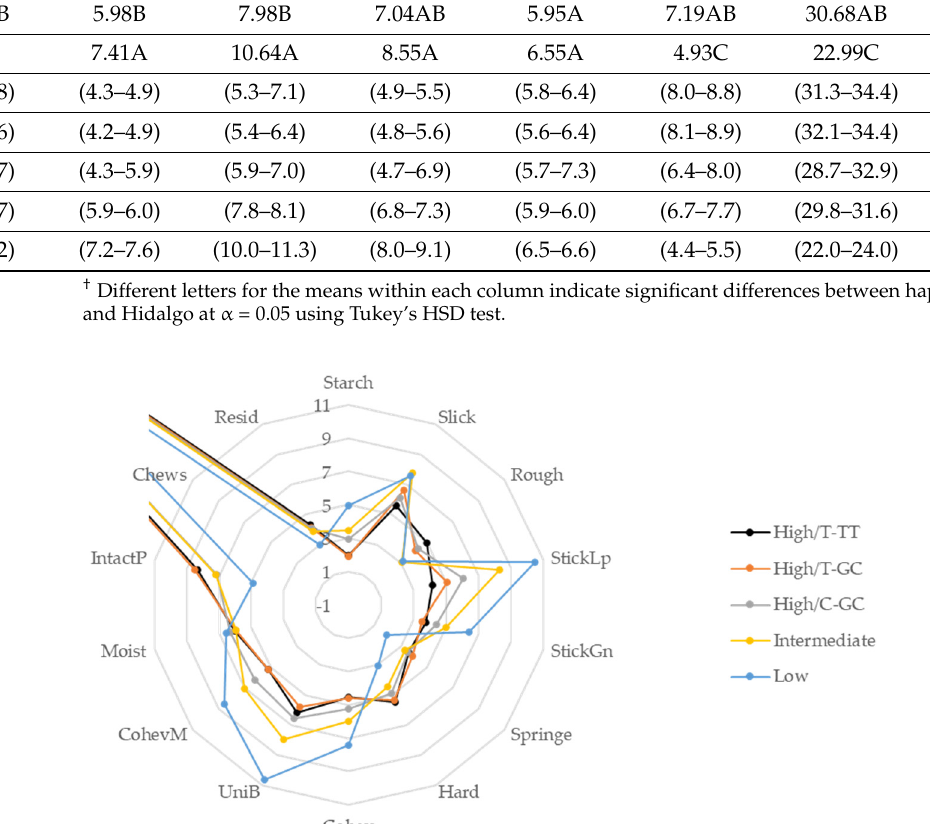
Pairwise correlation of grain quality traits with the texture attributes is presented in Table S5. RS and protein were positively ( r = 0.47 and 0.49, respectively, both at p < 0.05) and Tp was negatively correlated with Rough ( r = − 0.59, p < 0.01). Protein was also posi- tively correlated with StickGn ( r = 0.45, p < 0.05). Tp was also positively correlated with Starch, StickLp and negatively with residuals ( r = 0.52 at p < 0.05; r = 0.65 at p < 0.01; r = − 0.45 at p < 0.05, respectively). Pairwise correlation among texture attributes of high am- ylose varieties showed that some attributes were highly correlated with others, specifi- cally, Starch, CohevM, IntactP, Hard, and Cohev. PCA analysis of grain quality traits and texture attributes of high amylose varieties are presented in Table 7 and Figure 3. The first three PCAs accounted for a total of 63.3% variance with PC1, PC2 and PC3 having 36.6%, 15.9% and 10.9%, respectively. PC1 in- cluded (eigenvector > |0.25|) positive loadings of Starch, StickLp, Cohev, CohevM, and Tp and negative loadings of Hard, IntactP, and Chews. PC2 included (eigenvector > 0.35) RS, AAC, protein, Rough and StickGn. PC3 was primarily loaded with two variables, ∆ H and Slick. The score plot (Figure 3a) shows PC1 divides high amylose varieties based on the Waxy exon 10 SNP in that C-GC varieties are clustered on the positive scale of PC1 and T-TT and T-CC varieties are clustered on the negative scale of PC1, while PC2 divided varieties having higher and lower RS. StickGn and Rough were two texture attributes that had higher loading for PC2 compared to PC1. Table 7. PCA analysis of traits of grain quality and texture attributes † . Table 1